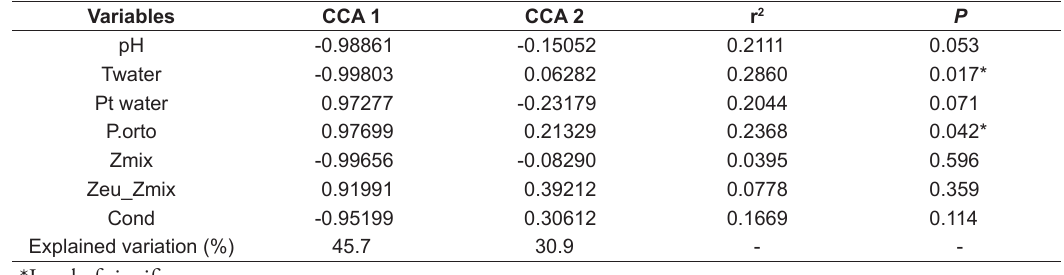
Table 2. Summary of the Canonic Correspondence Analysis showing correlation coefficients among the phytoplankton functional groups and the environmental variables of the Santa Lucia Lake for the period August 2014 to June 2015.